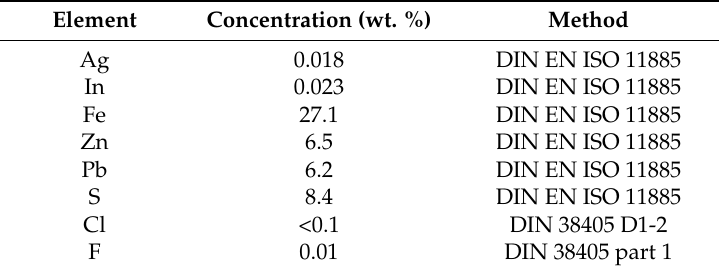
Table 2. Typical elemental analysis of a jarosite sample [12].